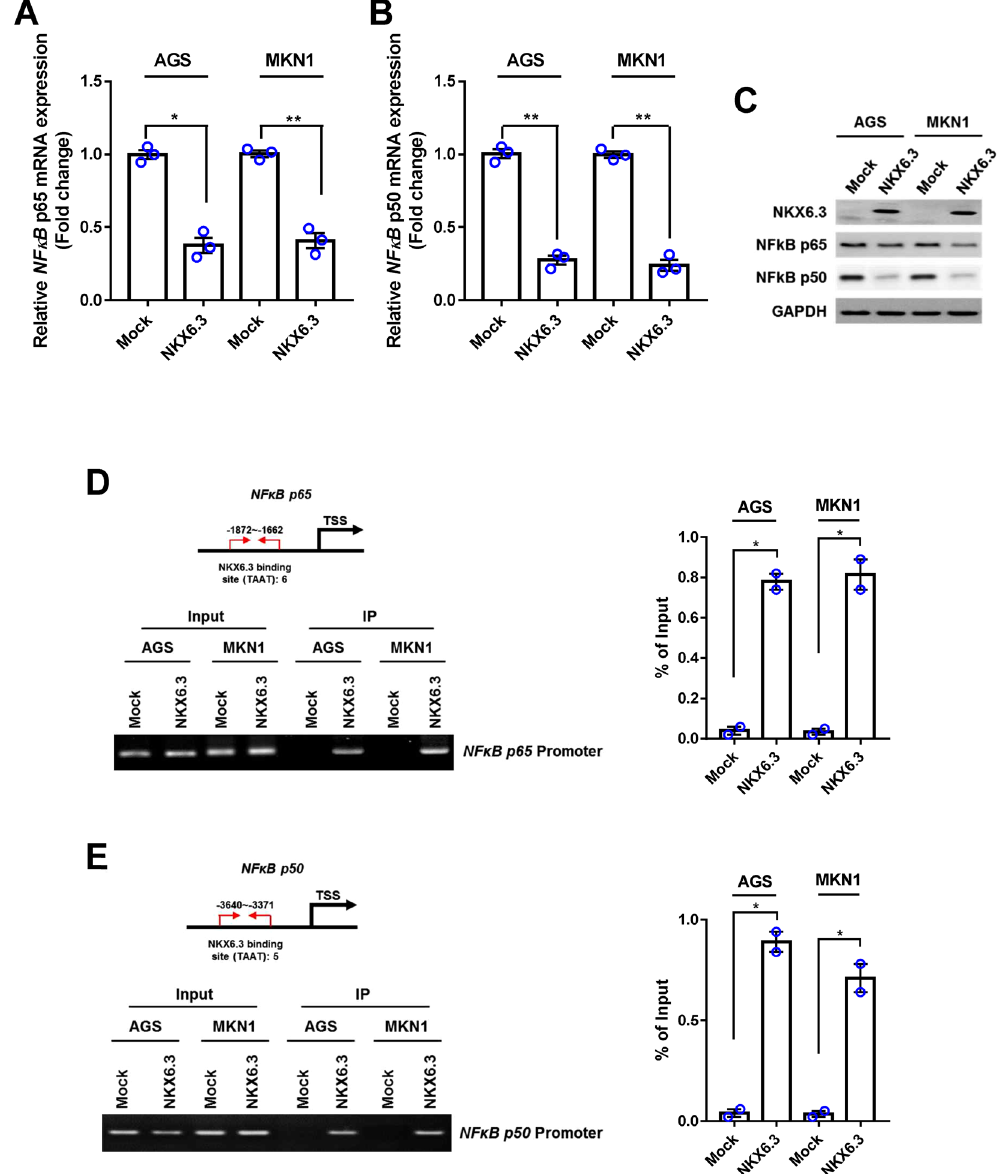
Figure 4. NKX6.3 negatively regulates NF-kB expression and activity. (A) NKX6.3 decreased the expression of NF-kB subunit p65 mRNA transcript in real-time PCR analysis. Results are represented as mean ± SEM from three independent experiments. (B) NKX6.3 reduced NF-kB subunit p50 mRNA expression in AGS and MKN1 cells. Results are represented as mean ± SEM from three independent experiments. (C) In AGS and MKN1 cells, NKX6.3 reduced expression of NF-kB p65 and p50 proteins in western blot analysis. ( D and E ) ChIP and ChIP-qPCR analyses of NKX6.3 binding to the promoters of NF-kB p65 (D) and p50 (E) genes. The results are represented as mean ± SEM from two independent experiments. Each dot plot represents the result from the individual experiment. ** P < 0.01, * P < 0.05, based on the student’s